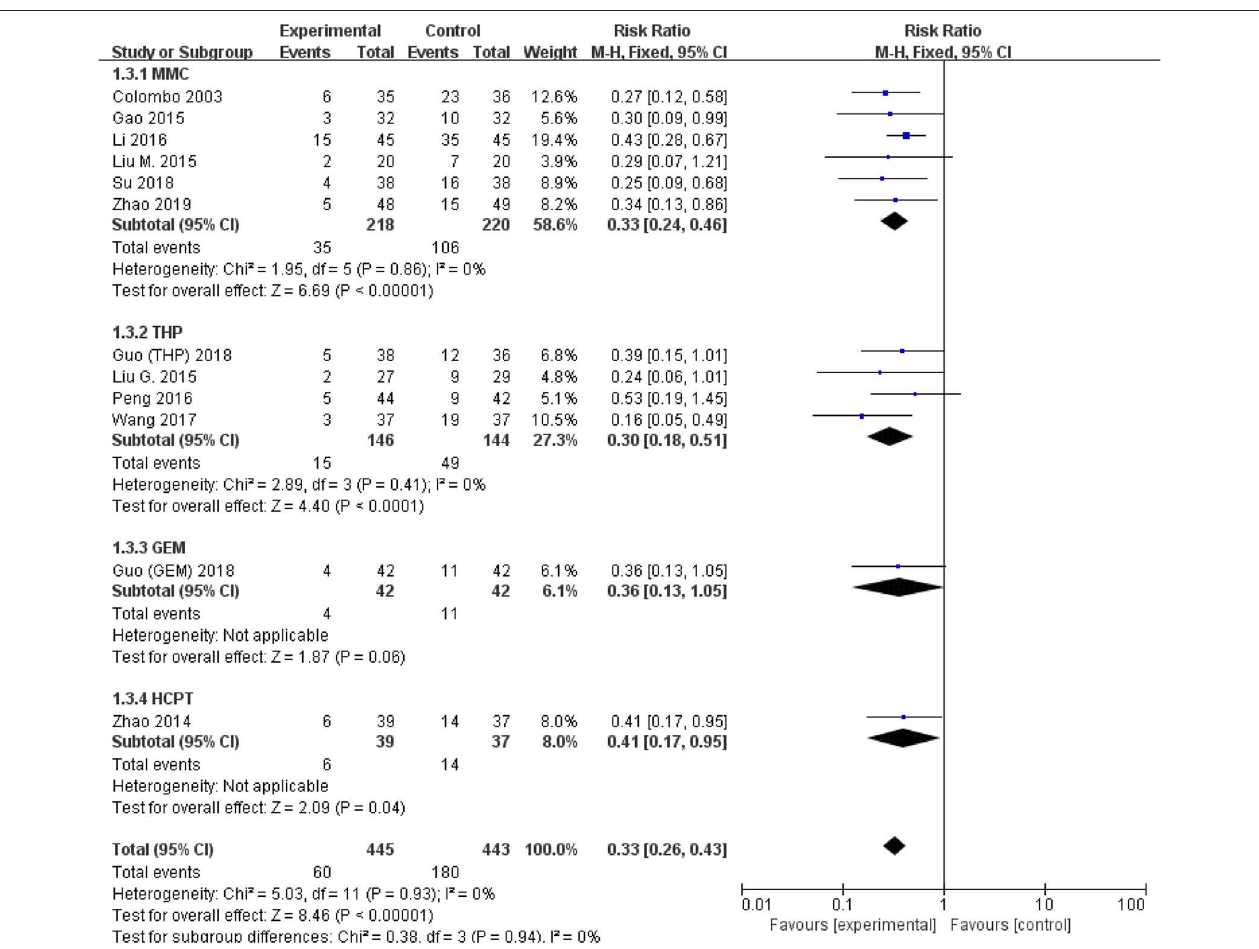
FIGURE 6 | Comparison on recurrence rate between thermal therapy and intravesical chemotherapy after subgroup analysis stratified by chemotherapeutic agent used in thermal intravesical chemotherapy.